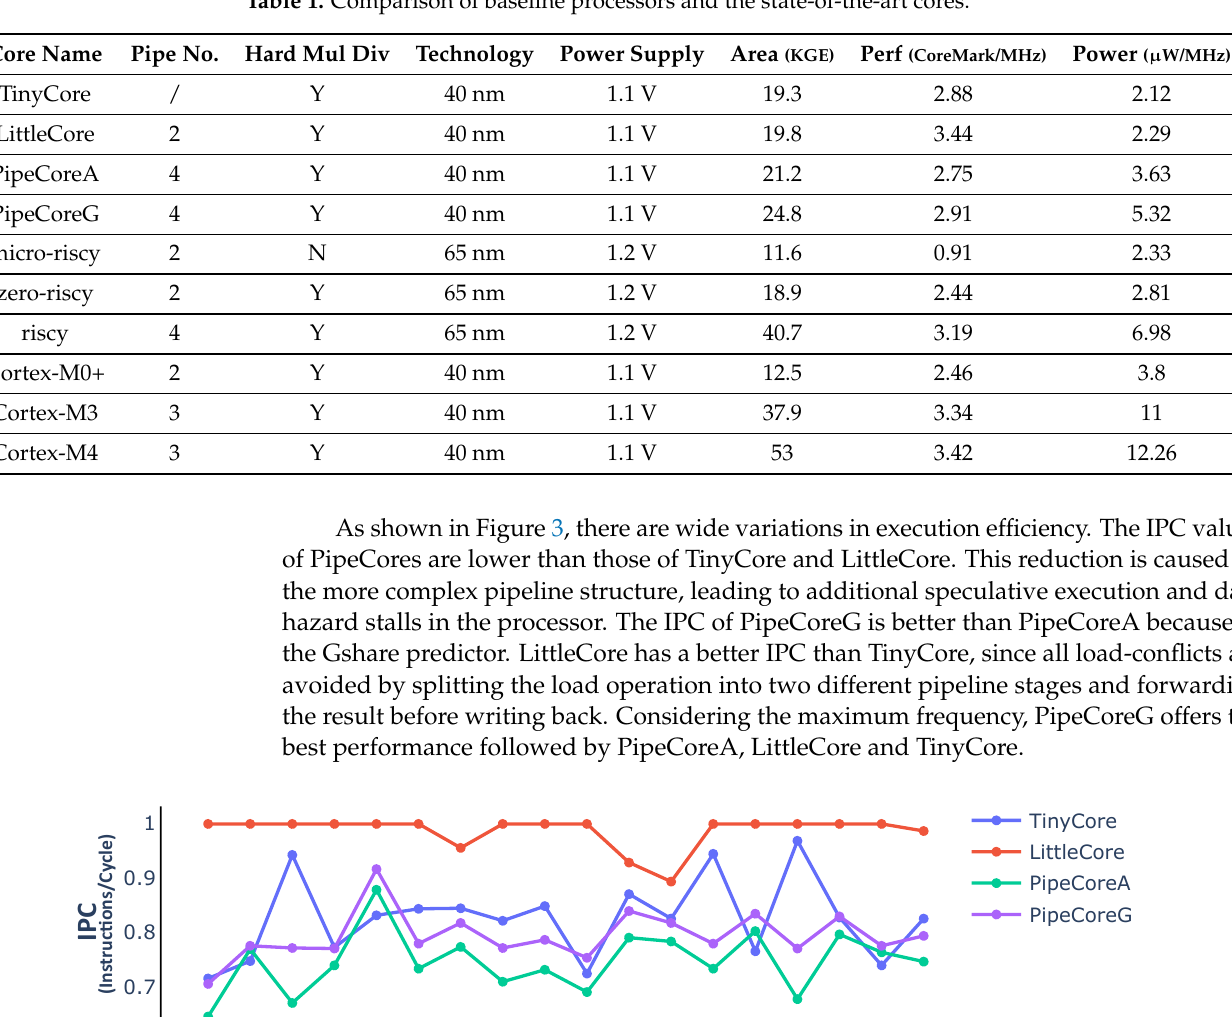
Table 1. Comparison of baseline processors and the state-of-the-art cores.